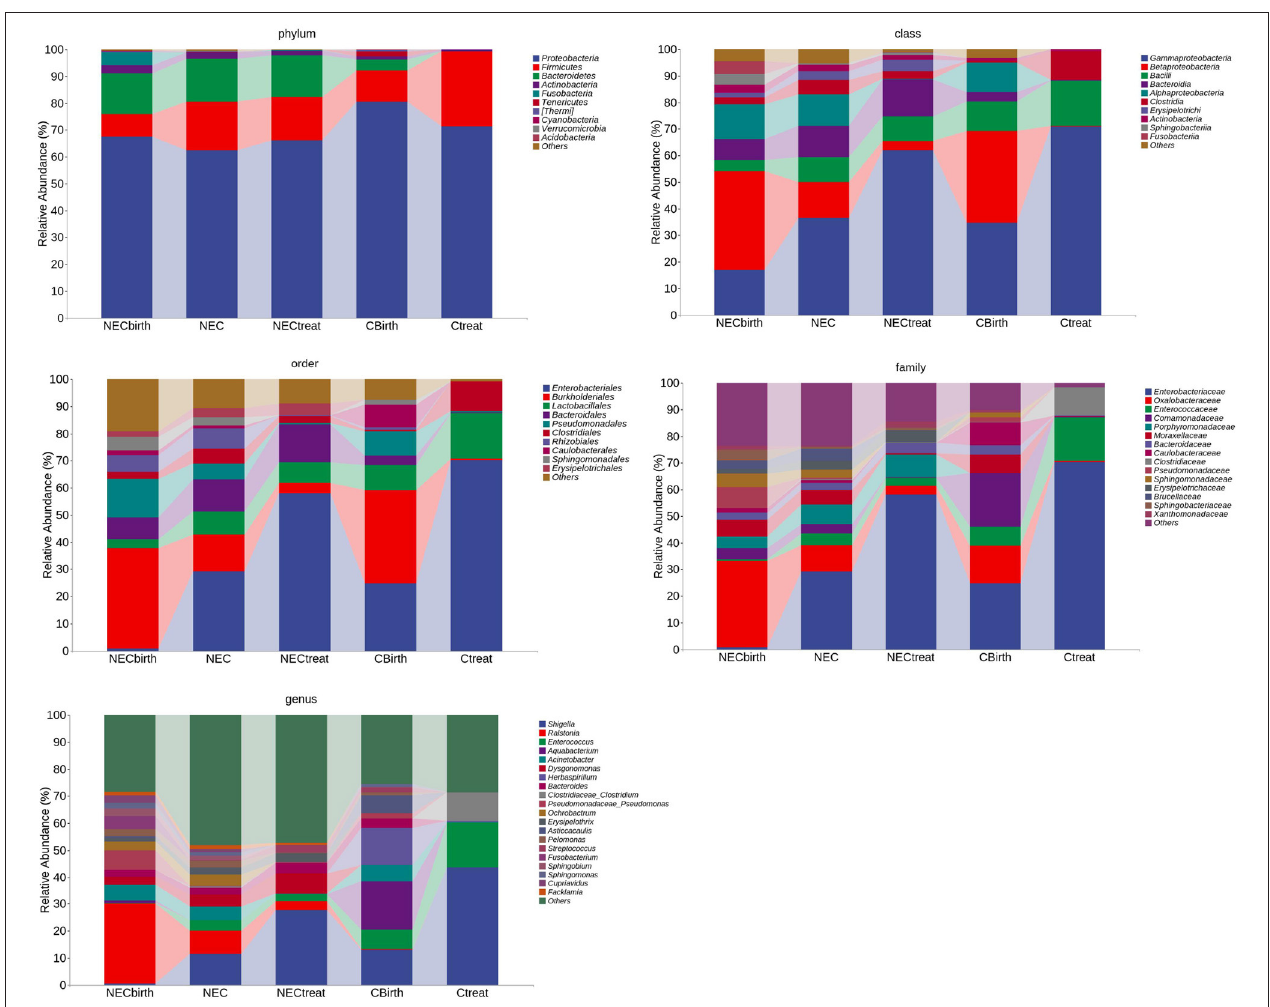
FIGURE 3 | Taxonomic composition analysis. This figure shows the bacteria at the top of each taxonomic level, the top 10 at the phylum, class, and order levels, the top 15 at the family level, and the top 20 at the genus level.